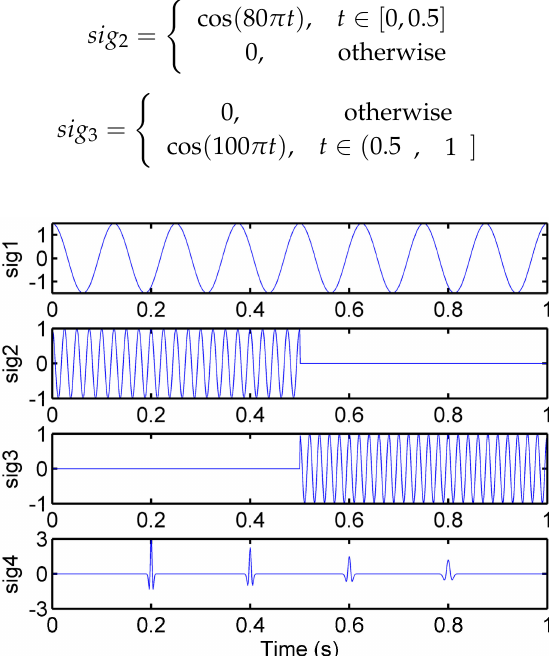
Figure 5. The components of the synthetic signal.